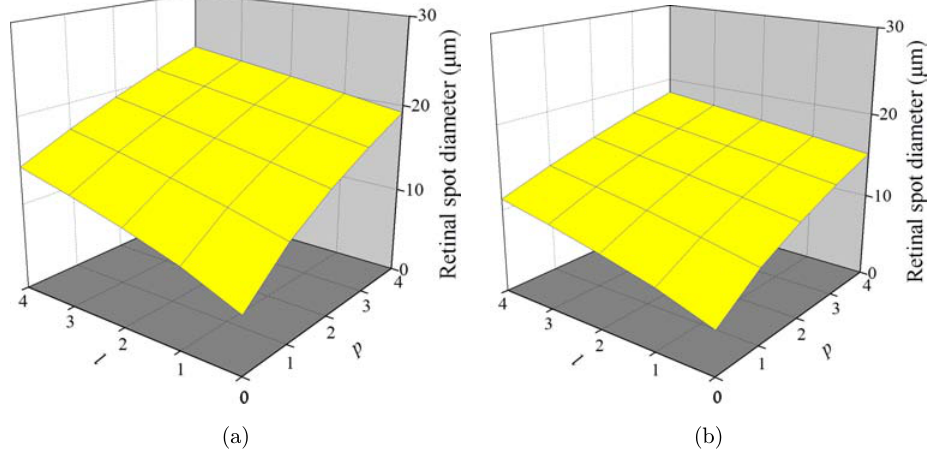
Fig. 6. Retinal spot diameter versus radial order p and azimuthal order l of transverse mode for human eye (a) and macaque eye (b). The beam divergence of the embedded TEM 00 mode is 0.2 mrad, other parameters are same with Fig.